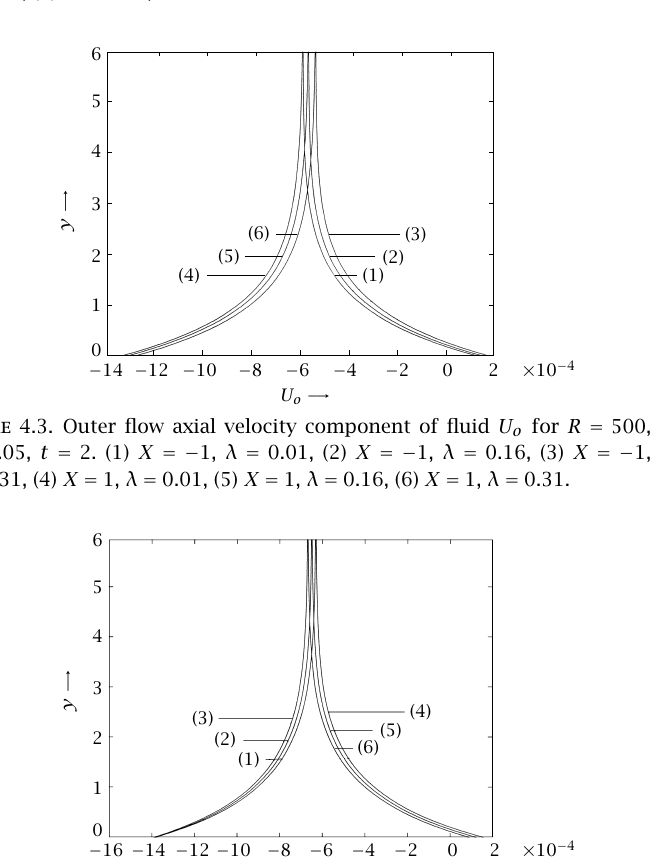
Figure 4.2 . Induced steady axial velocity component of the particle U the boundary layer for R = 500, 4 = 0 . 05. (1) X = − 0 . 1, λ = 0 . 01, (2) X = − 0 . 1, λ = 0 . 36, (3) X = − 0 . 1, λ = 0 . 71.